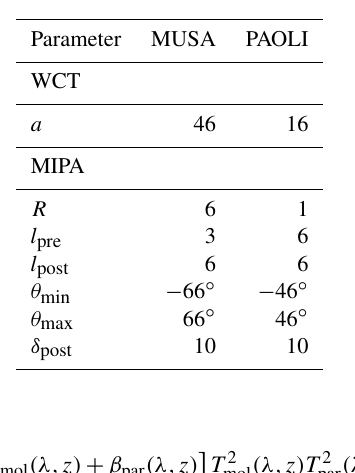
Table 1. Parameter setting for the WCT and MIPA approaches. The values of the parameters can be different for different lidar systems. Thus, they are reported for both the MUSA (Potenza) and PAOLI (Évora) lidar